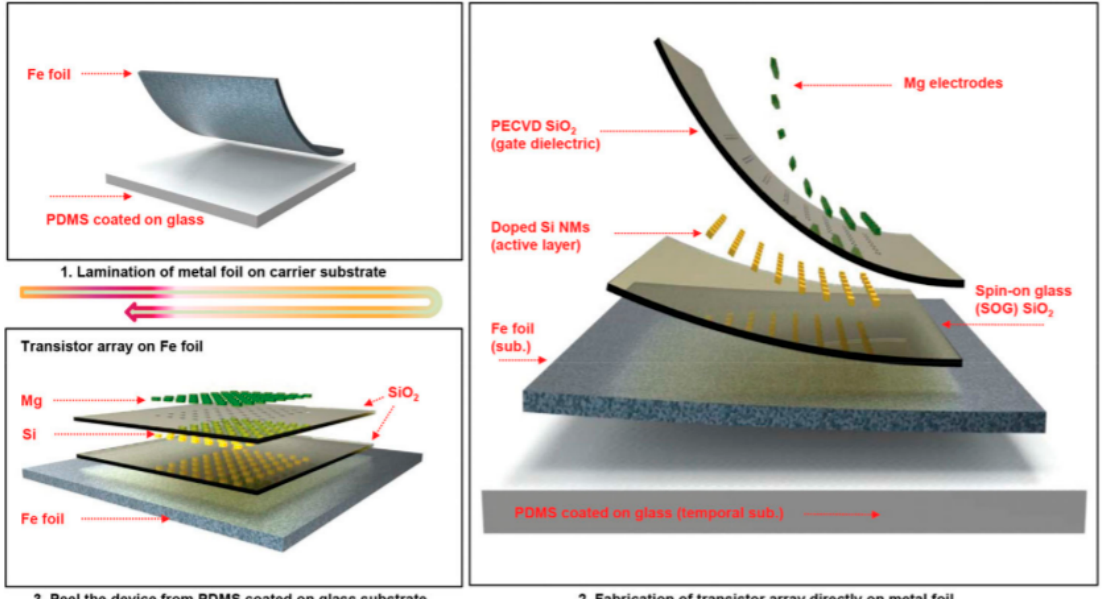
Figure 10. Fabrication steps of a transcient n-MOSFETs array on a biodegradable Fe foil: lamination of a Fe foil on a PDMS-coated glass substrate and exploded views of one MOSFET. Detachment from the PDMS/glass substrate gives a free-standing film. The materials include silicon nanomembranes (Si NMs; semiconductor), thin Mg films (conductor), spin-on glass (SOG) SiO 2 (dielectric), and Fe foil (substrate). Adapted from [45] with permission. Copyright © 2015 Wiley and Sons.